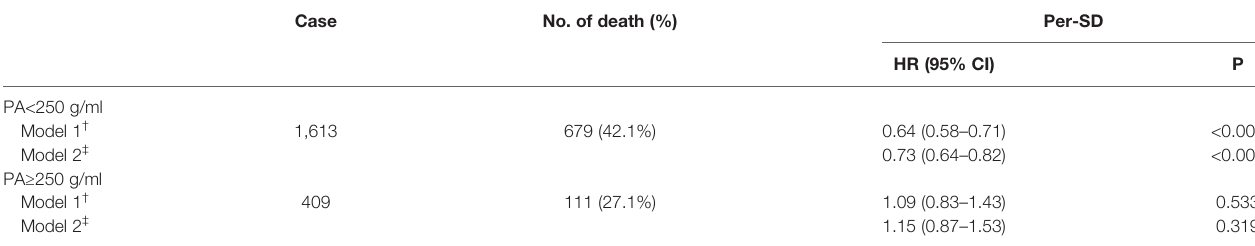
TABLE 5 | Threshold effect analysis of serum prealbumin on all-cause